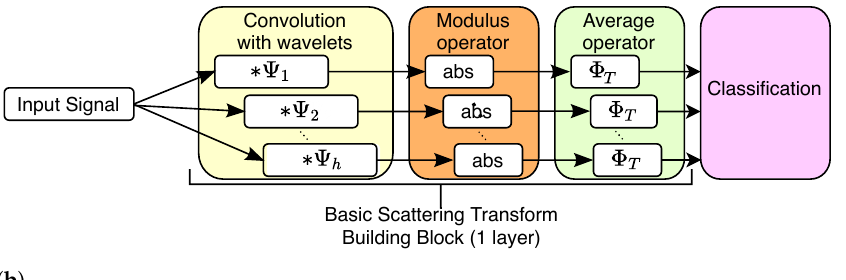
Figure 3. Typical simplified structures of convolutional networks. We show both CNN and ST structures with only one convolutional layer. Both approaches may have other topologies based on basic building blocks presented in this figure. ( a ) Simple CNN-based classification structure. ( b ) First-order ST-based classification